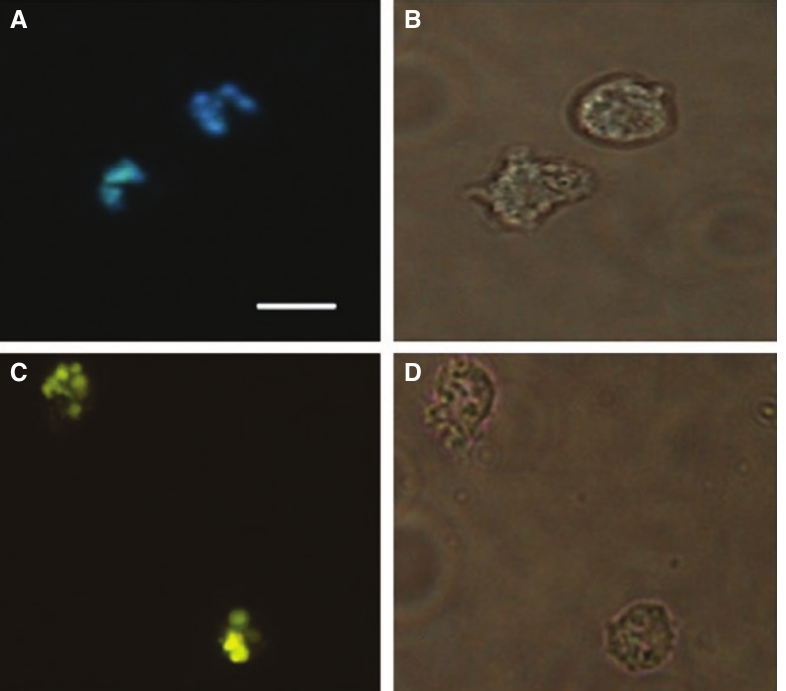
Figure 4: Auto-fluorescent vacuoles and lysosomes in stationary phase cells treated with 500 μ M chloroquine. (A) Fluorescence microscopy images of auto-fluorescent vacuoles and (B) light field microscopy images of the same cells. (C) Fluorescence microscopy images of lysosomes stained with NBD-PZ and (D) light field microscopy images of the same cells. Scale bar = 10 μ m.